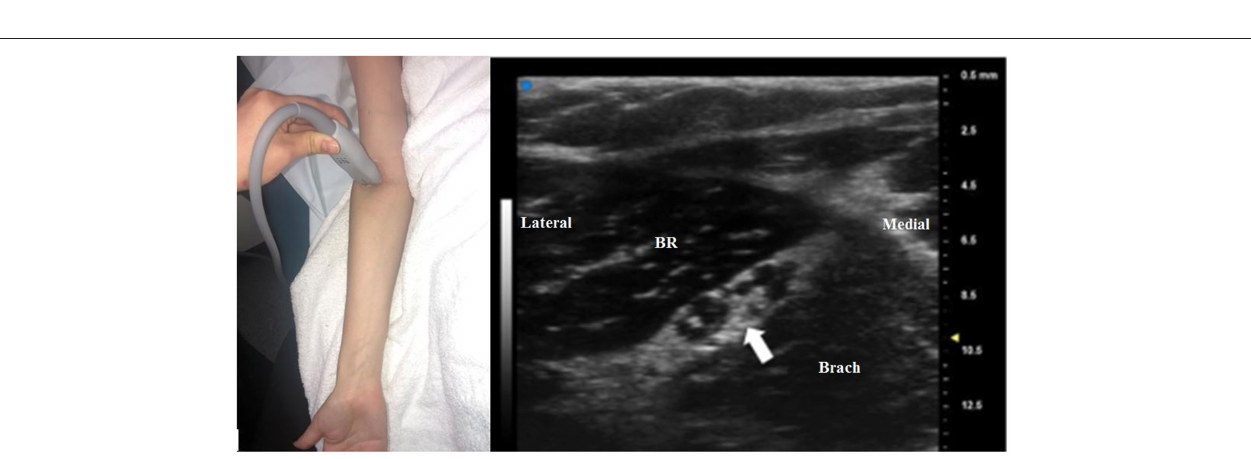
FIGURE 7 | An ultra-high frequency 48 MHz transducer is used to image the radial nerve (arrow) just proximal to the antecubital fossa. Two prominent groups fascicles can be seen within the radial nerve, and the lateral group of fascicles will become the deep branch of the radial nerve and the medial fascicles will be become the superficial branch. This matches with the site of Figure 1 , but the fascicular structure of the nerve can be seen in more detail. BR, brachioradialis; Brach, brachialis.